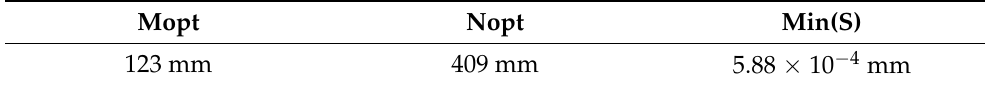
Table 1. Calibration results of parameters M and